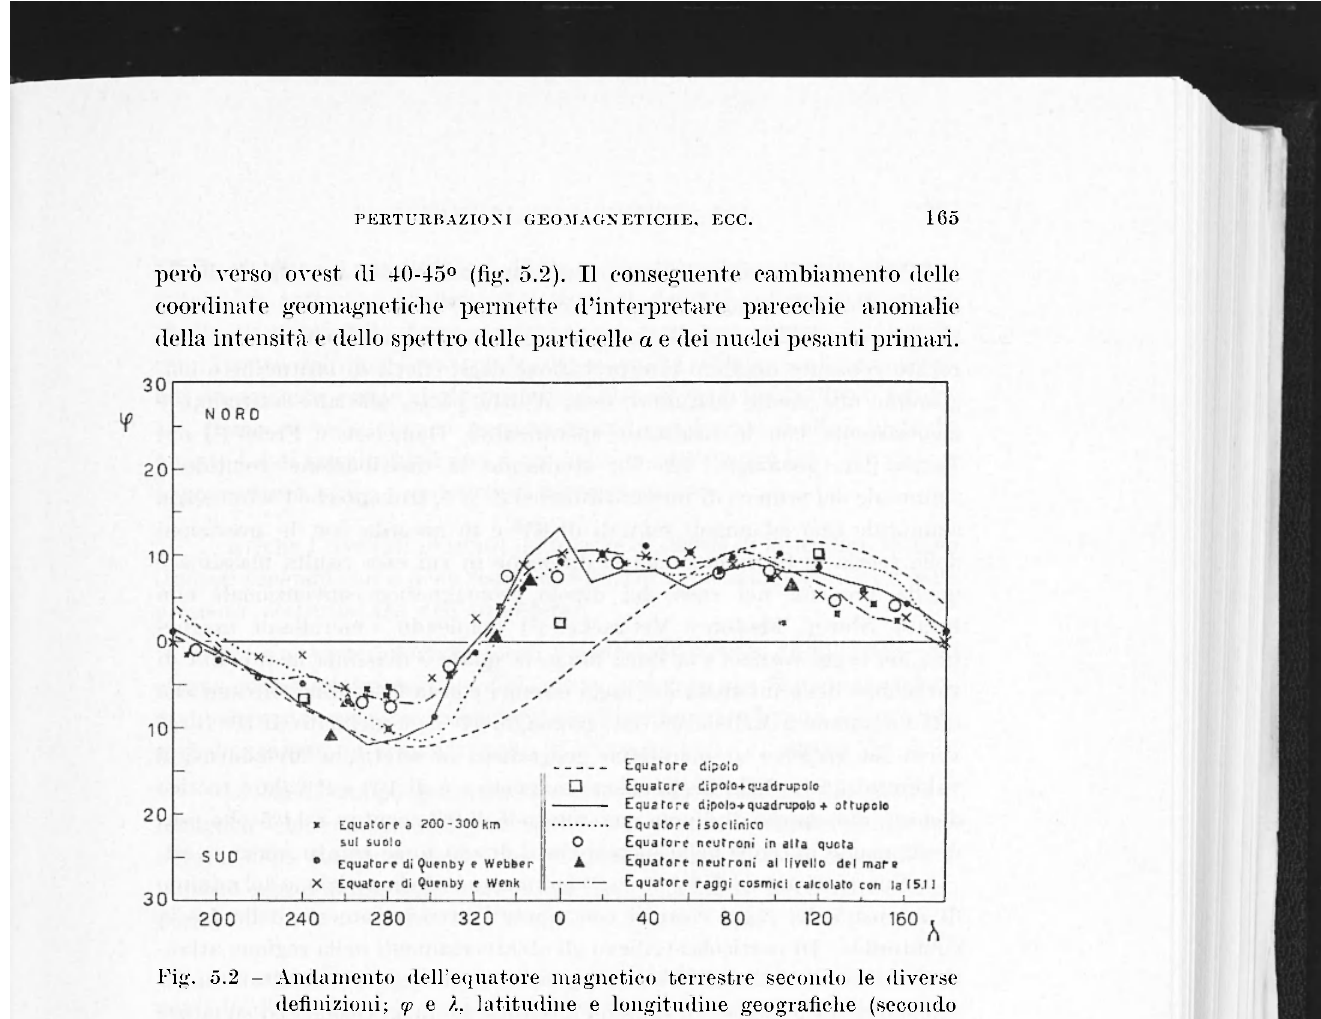
Fig. 5.2 - Andamento dell'equatore magnetico terrestre secondo le diverse definizioni; <p e A, latitudine e longitudine geografiche (secondo Kellogg e Schwartz; Rothwell; Vernov e coli., Quenby e Web- ber: Quenby e Wenk).